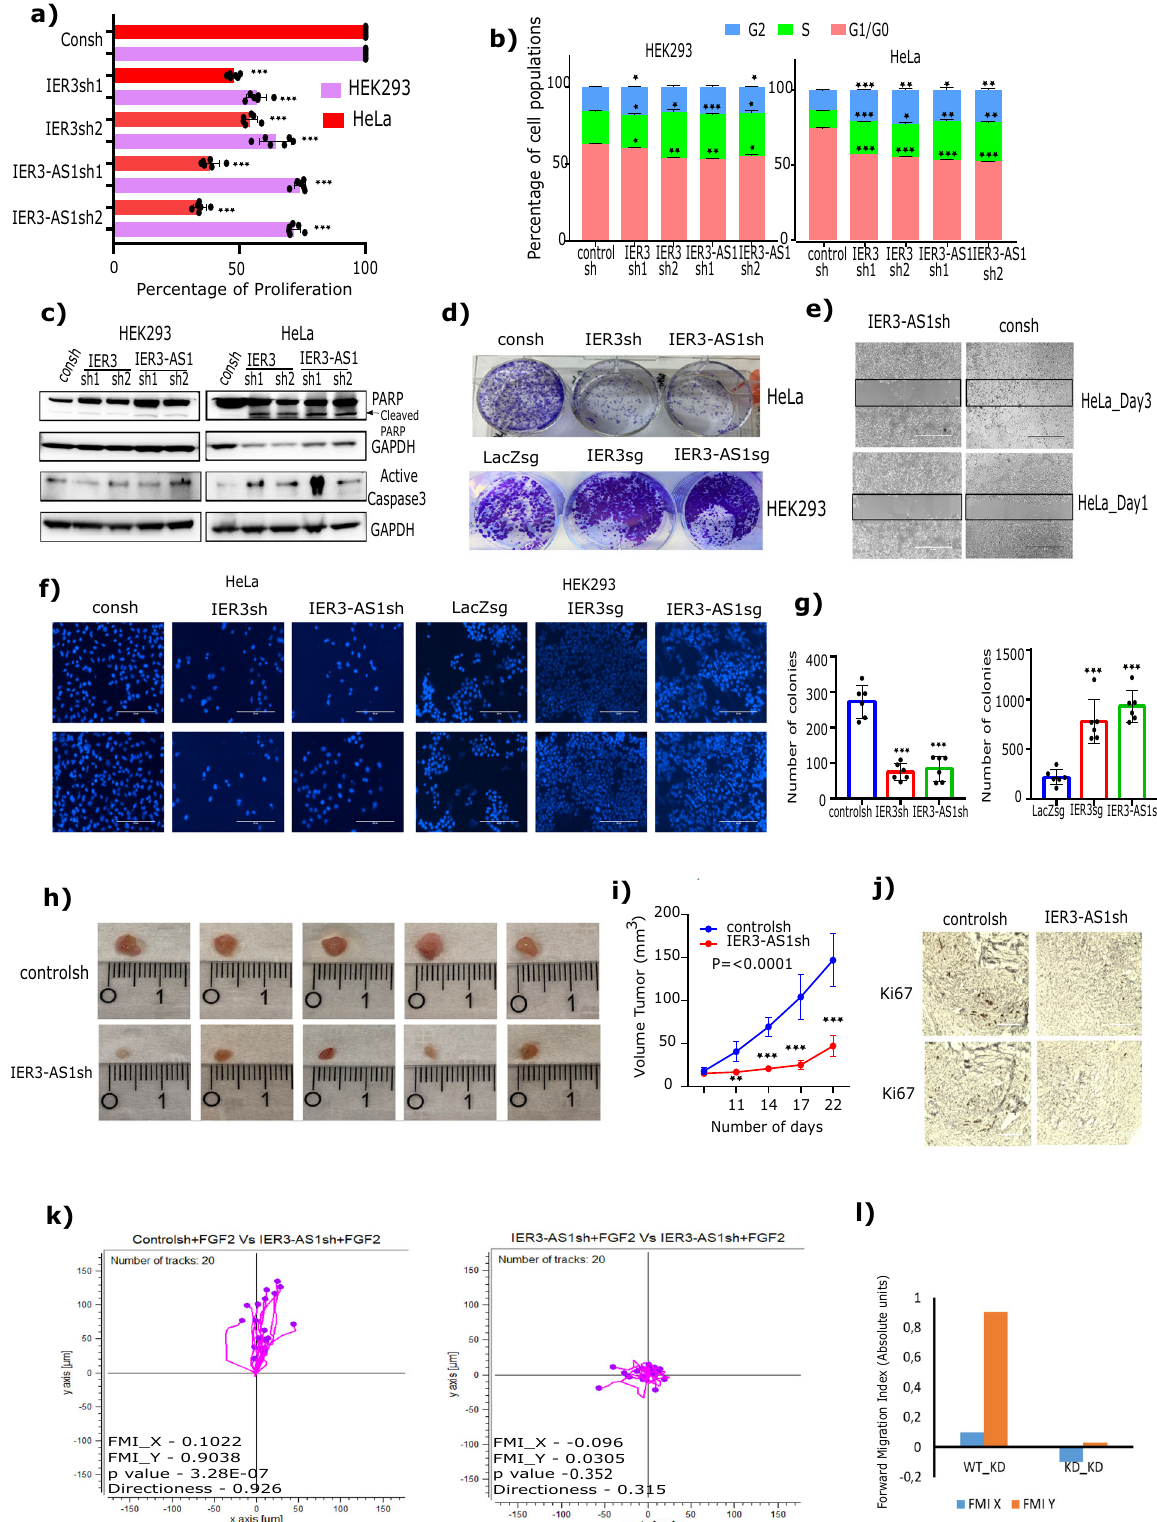
IER3 and IER3-AS1 show colocalization and control each other ’ s stability IER3 and IER3-AS1 are sense-antisense transcripts encoded from a convergent pair of genes, which share a 325 bp overlapping region in their downstream exon 2 region (Fig. 3a). Using the bio.tools software 13 , we identi fi ed the IER3 and IER3-AS1 interacting regions